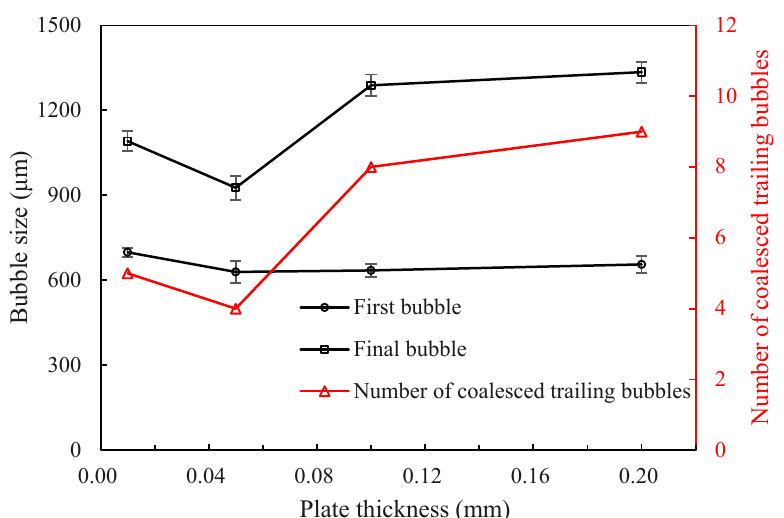
Figure 7. Effects of plate thickness on bubble size and number of coalesced trailing bubbles under oscillatory air pattern.